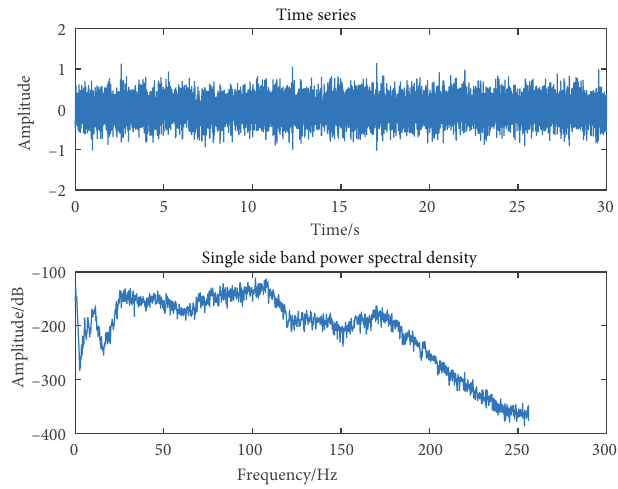
Figure 15: Time series and PSD of the horizontal tail in CH3.